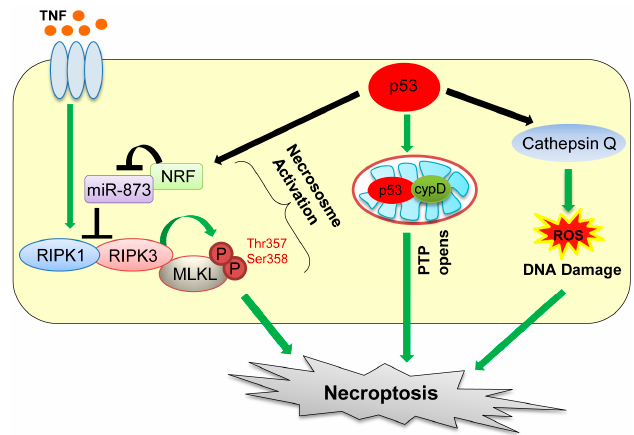
Figure 3. Mechanisms of necroptosis mediated by p53. p53 induces necroptosis by transactivating necrosis-related factor (NRF) and cathepsin Q and also directly binding with cyclophilin D (cypD). TNF: tumor necrosis factor; MLKL: mixed lineage kinase domain-like protein; miR: microRNA; PTP: permeability transition pore; RIPK: receptor-interacting serine/threonine protein kinase.